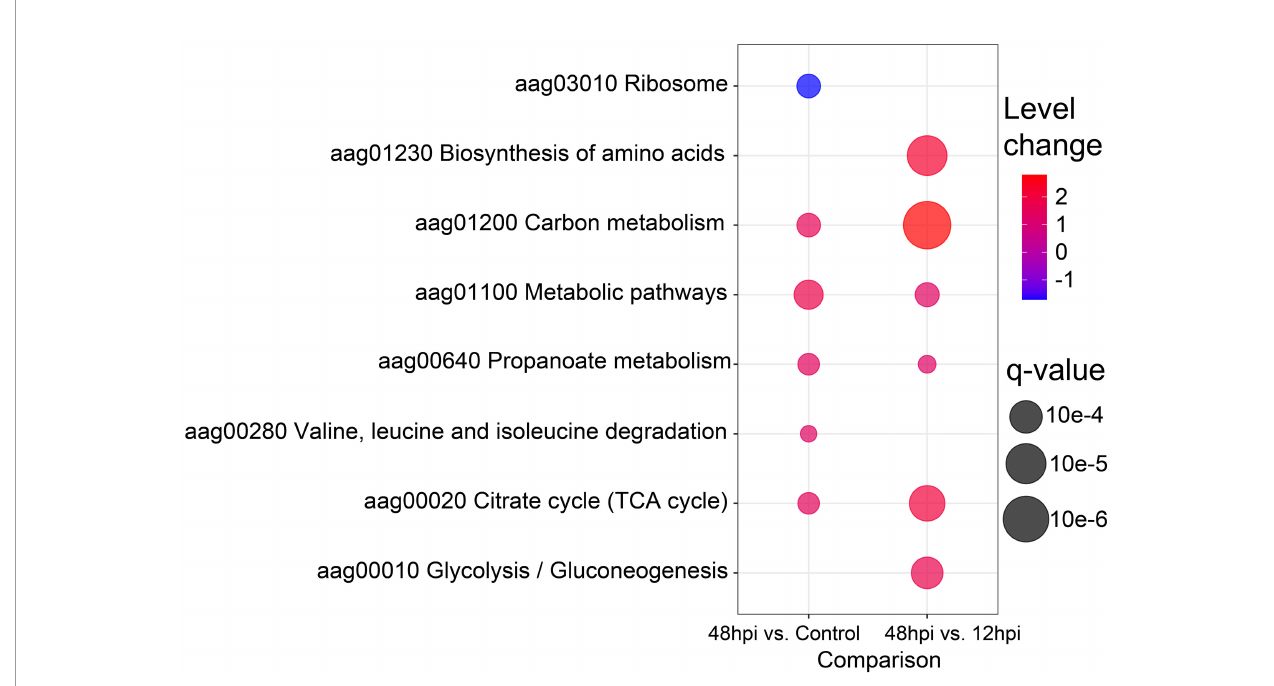
FIGURE 6 | Bubble plot of enriched Kyoto Encyclopedia of Genes and Genomes (KEGG) pathways. The eight enriched KEGG pathways by Generally Applicable Gene-set Enrichment (GAGE) analysis (q-value < 0.1) are shown in a bubble plot according to their q-values and level changes, where level changes represent the magnitude of KEGG pathway variation, and q-value the signi fi cance for each gene-set enrichment.